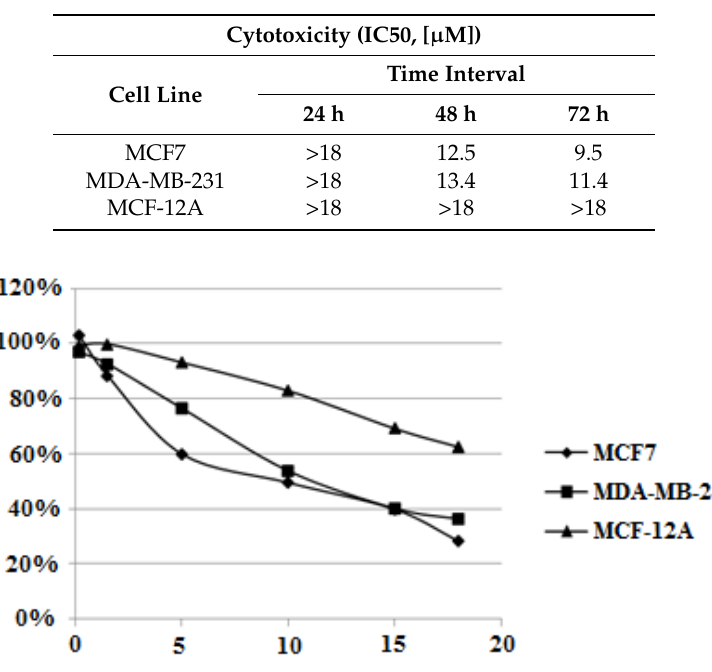
Table 5 In vitro cytotoxicity of carbazole derivative 3 on selected cell lines. Table 5. In vitro cytotoxicity of carbazole derivative 3 on selected cell lines.